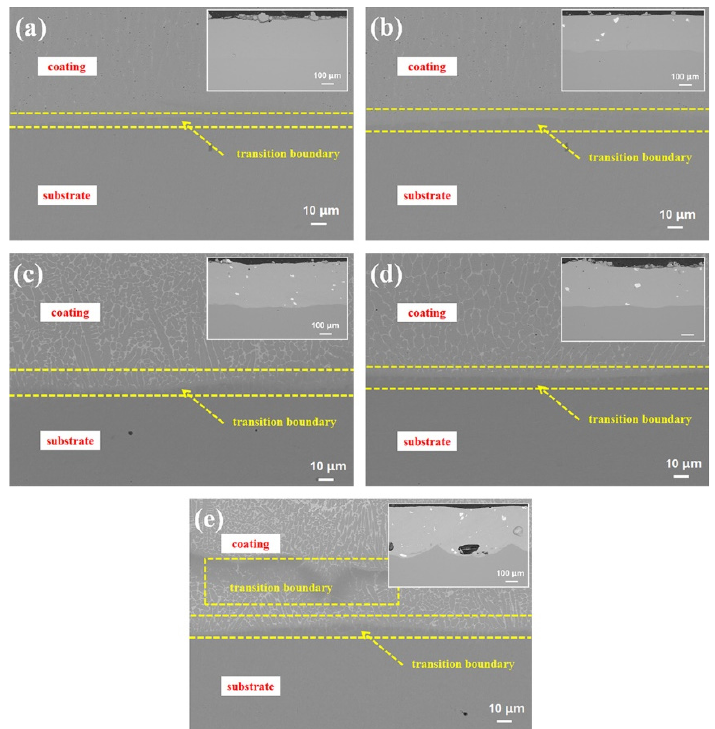
Figure 5. Cross ‐ sectional FESEM images of coatings: ( a ) CoCrFeNi HEAC; ( b ) CoCrFeNi HEACC (10 wt.% WC); ( c ) CoCrFeNi HEACC (20 wt.% WC); ( d ) CoCrFeNi HEACC (30 wt.% WC); ( e ) CoCrFeNi HEACC (40 wt.% WC).